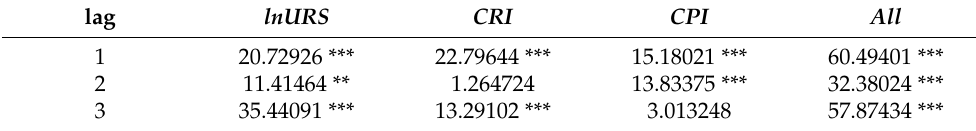
Table 6. Joint significance test results.